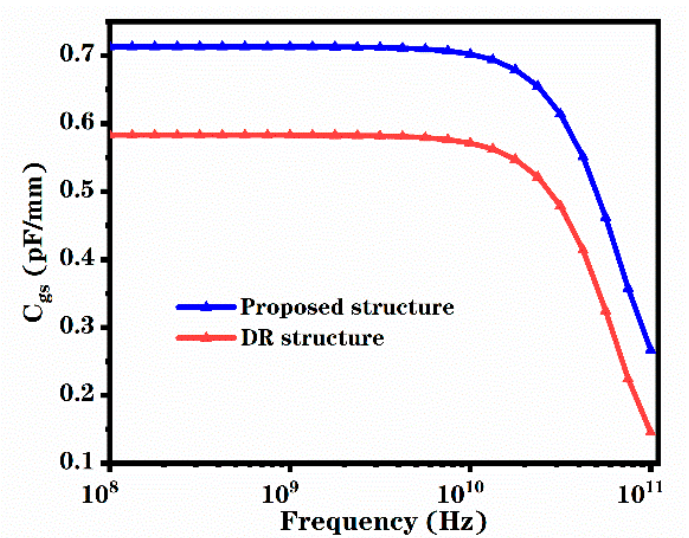
Figure 7. Relationship between C gs and frequency for the proposed structure and DR structure at V gs = 0 V and V ds = 40 V. V gs = 0 V and V ds = 40